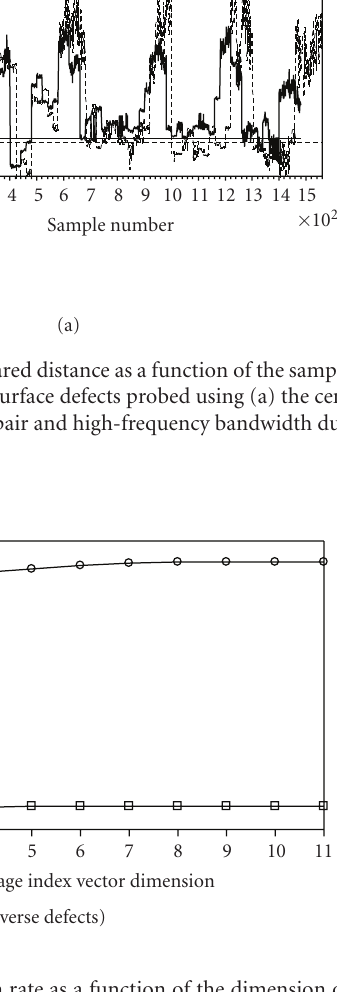
Figure 9: Average detection rate as a function of the dimension of the damage index vector as a result of probing transverse defects with central sensor pairs and high-frequency bandwidth in Test